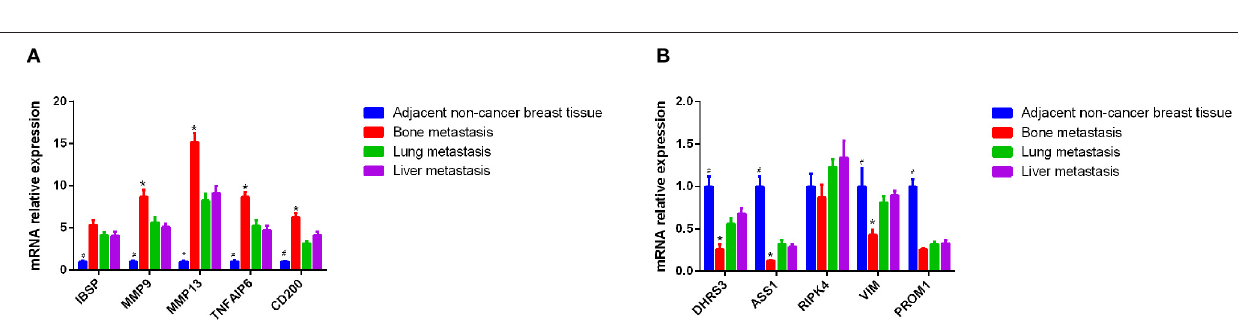
FIGURE 5 | Identification of differential mRNA by QRT-PCR using metastatic bone, liver, and lung tissues. (A) Expression of IBSP, MMP9, MMP13, TNFAIP6, and CD200 in the tissue of patients with breast cancer bone metastasis, lung metastasis and liver metastasis by qRT-PCR. The x axis and y axis presented gene name and relative expression, respectively. (B) Expression of DHRS3, ASS1, RIPK4, VIM, and PROM1 in the tissue of patients with breast cancer bone metastasis, lung metastasis, and liver metastasis by qRT-PCR. The x axis and y axis presented gene name and relative expression, respectively. # P < 0.05, adjacent non-tumor breast tissue compared with three site metastases; * p < 0.05, bone metastasis compare with lung and liver